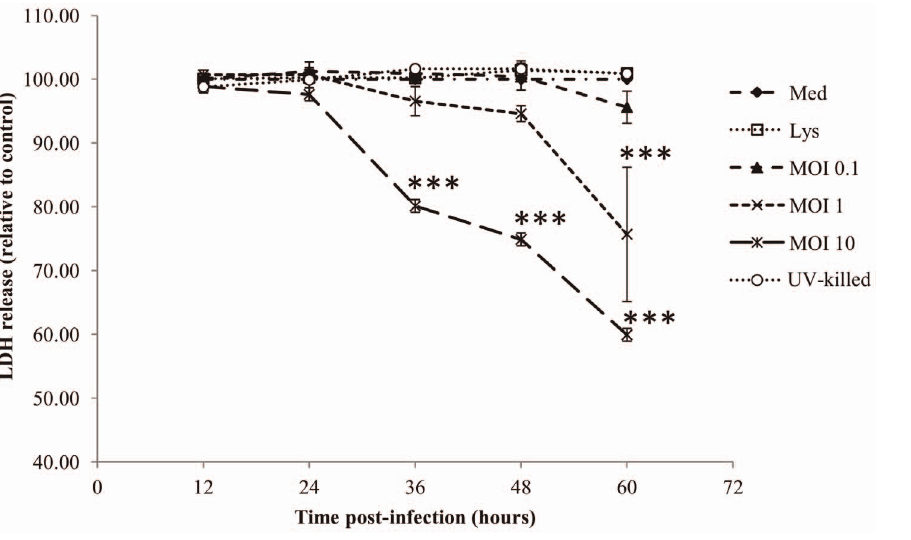
Figure 3. Changes in host cell viability over time after exposure of AH-1 trophoblasts to medium alone (Med), uninfected control cell lysate (Lys) or increasing MOI of W.chondrophila (MOI 0.1, 1, 10) or UV-killed organisms (MOI 10) quantified by lactate dehydrogenase release (n=3). Statistically-significant differences relative to medium control at each time-point are indicated by ***P , 0.001. Data were analysed by two-way ANOVA. Comparisons between individual treatments were made using Tukey’s multiple comparison test.